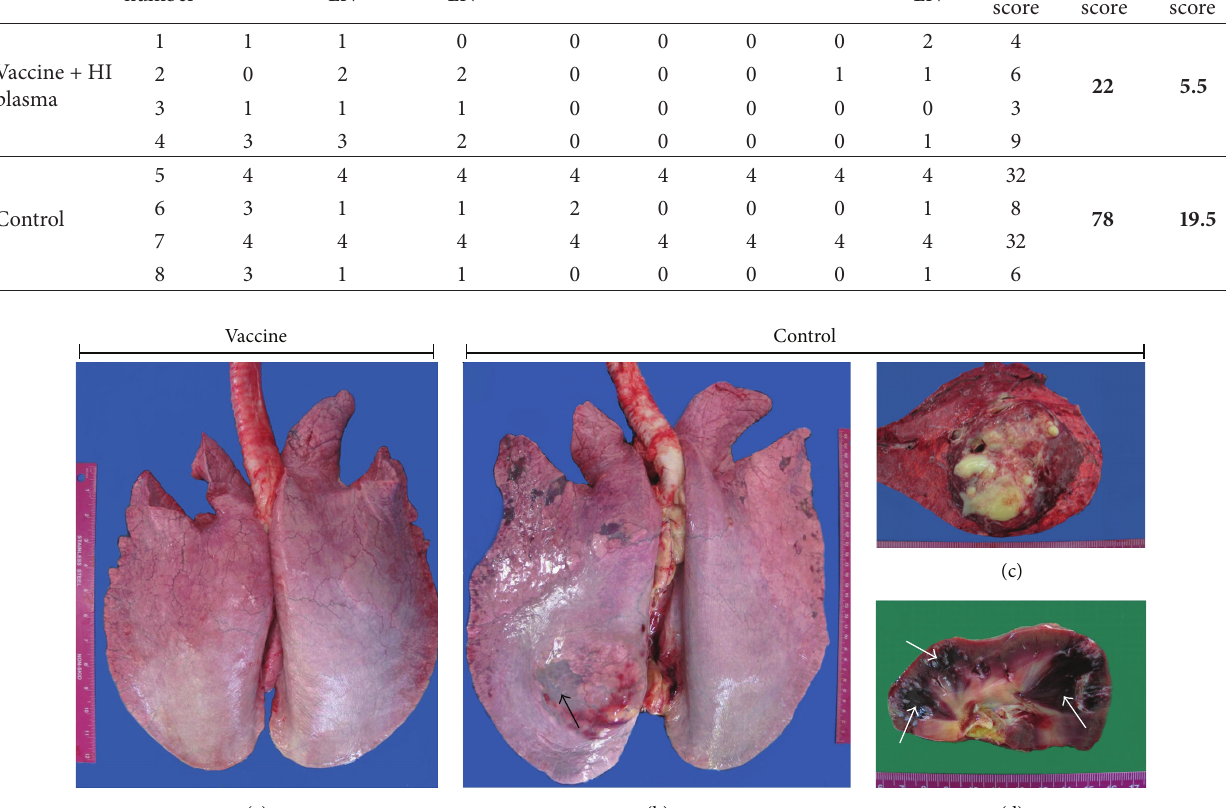
Figure 2: (a) Normal lung in a foal of vaccine group, (b) pyogranuloma formation in the R. equi inoculated left lung of a control foal (arrow), (c) pyogranuloma in lung, and (d) infarction areas in kidney of control foals (arrows).